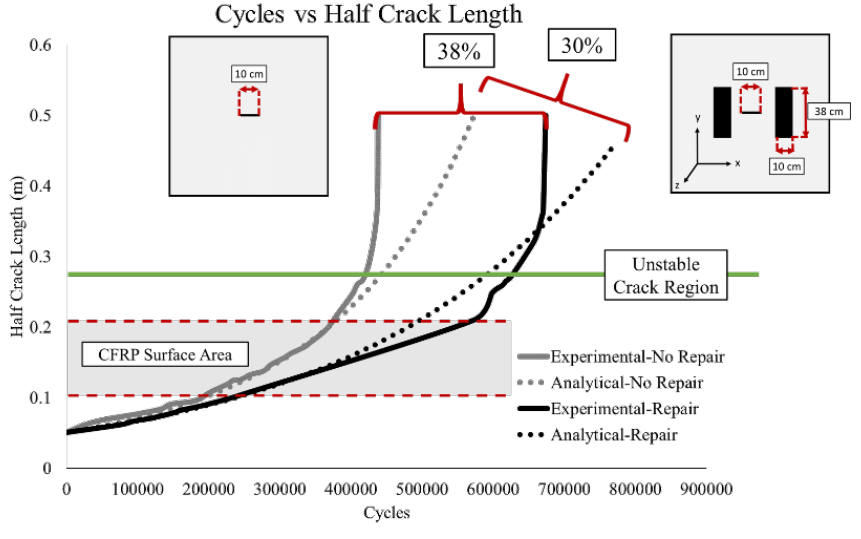
Figure 6. Cycles vs. half crack length results.